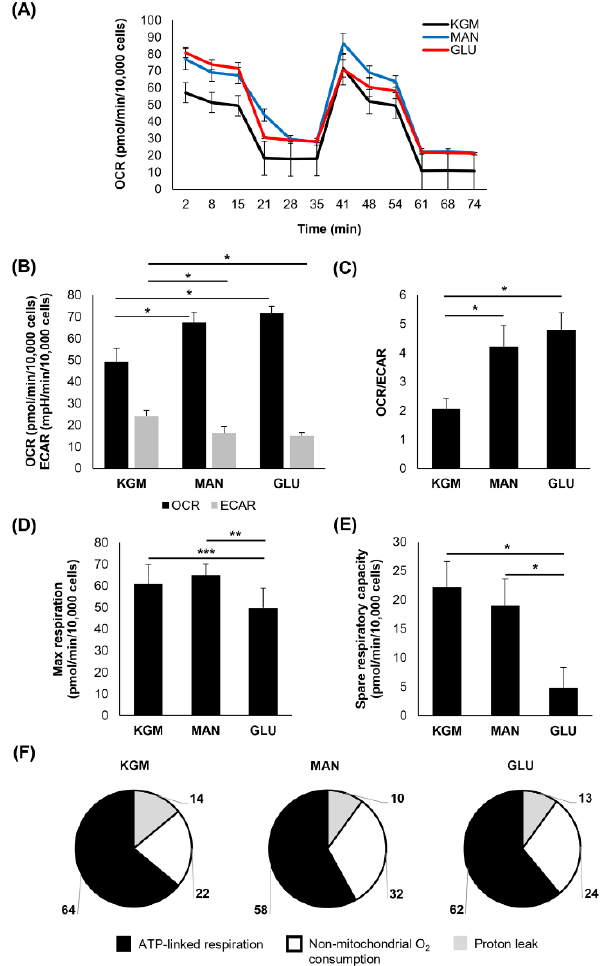
Figure 3. Spare respiratory capacity remained decreased in response to hyperglycemia after 7 days in culture. ( A ) OCR plotted as a function of time for both test and control groups. ( B ) OCR was increased in both glucose- and mannitol-treated cells (* p < 0.001), whereas ECAR was decreased compared to KGM (* p < 0.001). ( C ) There was a shift toward a more respiratory phenotype for cells cultured in glucose and mannitol (* p < 0.001). ( D ) Maximal respiration was decreased in cells treated with high glucose (** p = 0.038, *** p = 0.014). ( E ) Spare respiratory capacity was decreased only in cells cultured in high glucose (* p < 0.001). ( F ) The proportion of oxygen consumption due to ATP-linked respiration, non-mitochondrial oxygen consumption, and the proton leak in the KGM control compared to glucose- and mannitol-treated cells. Bar graphs are presented as mean ± standard deviation. Pie charts are presented as percentage of total oxygen consumption. Graphs are representative of one experiment that was repeated three independent times. One-way ANOVA on ranks with Dunn’s post hoc comparison test ( non-mitochondrial oxygen consumption) and one-way ANOVA with SNK multiple comparison test for all others.